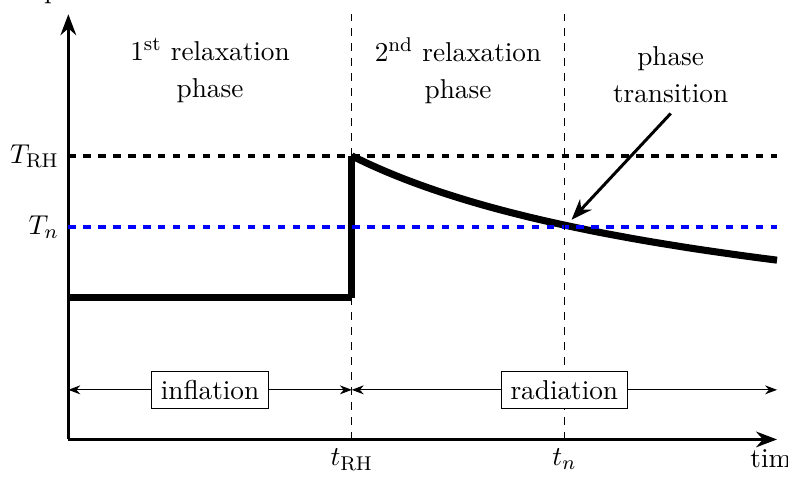
Figure 1. Sketch of the framework we are considering. The thick black line represents an ap- proximate sketch of the temperature evolution. During inflation, a first relaxation phase selects the correct EW vacuum. When reheating happens at t , the temperature increases and the radiation RH domination phase begins. For simplicity, we will consider reheating to be an instantaneous process. If the reheating temperature T is larger than the nucleation temperature T , the back-reaction RH n potential disappears and a second relaxation phase occurs. After a while, the temperature falls below the nucleation temperature of the new strongly interacting group, and a phase transition occurs which may generate a GW